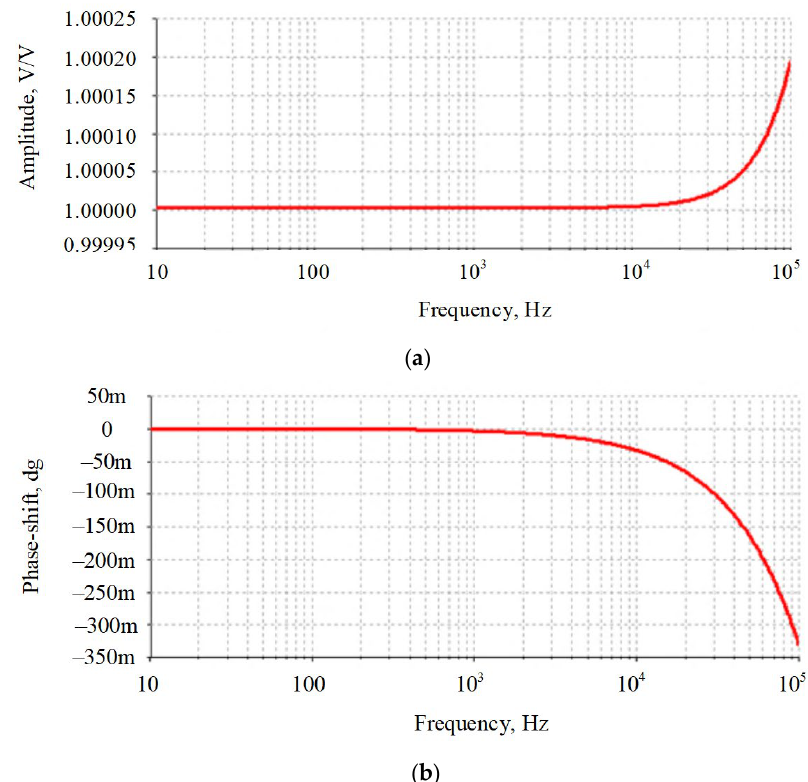
Figure 4. Amplitude frequency ( a ) and phase-shift-frequency ( b ) responses of the IA voltage follower output stage with embedded photovoltaic modules.